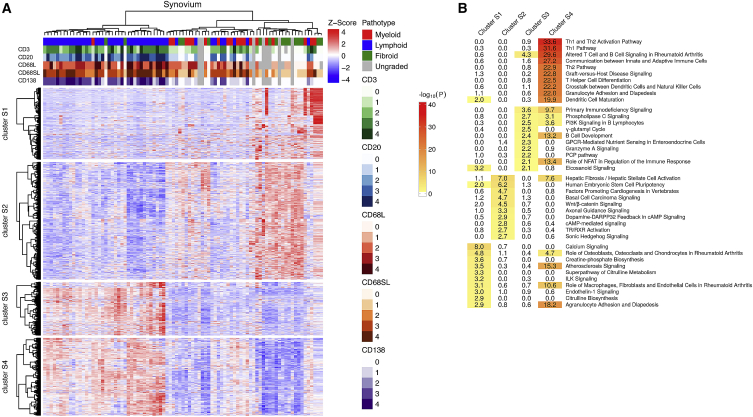
Clustering and Pathway Analysis of Differentially Expressed Genes in Rheumatoid Arthritis Synovium(A) Heatmap of 2,964 RNA-seq genes differentially expressed between three histological pathotypes (lympho-myeloid, diffuse-myeloid, and pauci-immune fibroid) (FDR < 0.05, n = 87). Upper tracks show histological scores for CD3, CD20, CD68L, CD68SL, and CD138 and overall pathotype. Unsupervised hierarchical clustering demonstrated clustering of genes into four clusters, demonstrating some overlap between the three histologically determined pathotypes.(B) Ingenuity Pathway Analysis performed on synovial gene clusters produced by hierarchical clustering identified pathways by gene enrichment, using whole genome as background. Clusters S1 and S2 represent pauci-immune fibroid and diffuse-myeloid samples, and clusters S3 and S4 represent lympho-myeloid and diffuse-myeloid samples. Color scale and numbers depict –log10 FDR-adjusted p values.